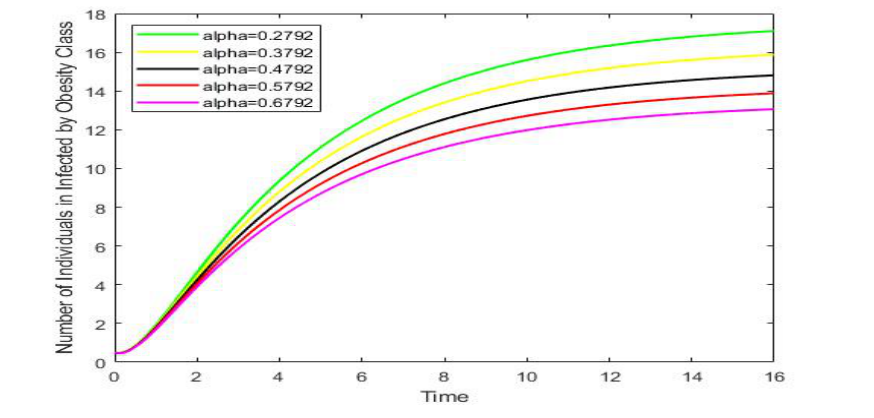
Figure 5: Infected by Obesity class for different values of α with control parame-